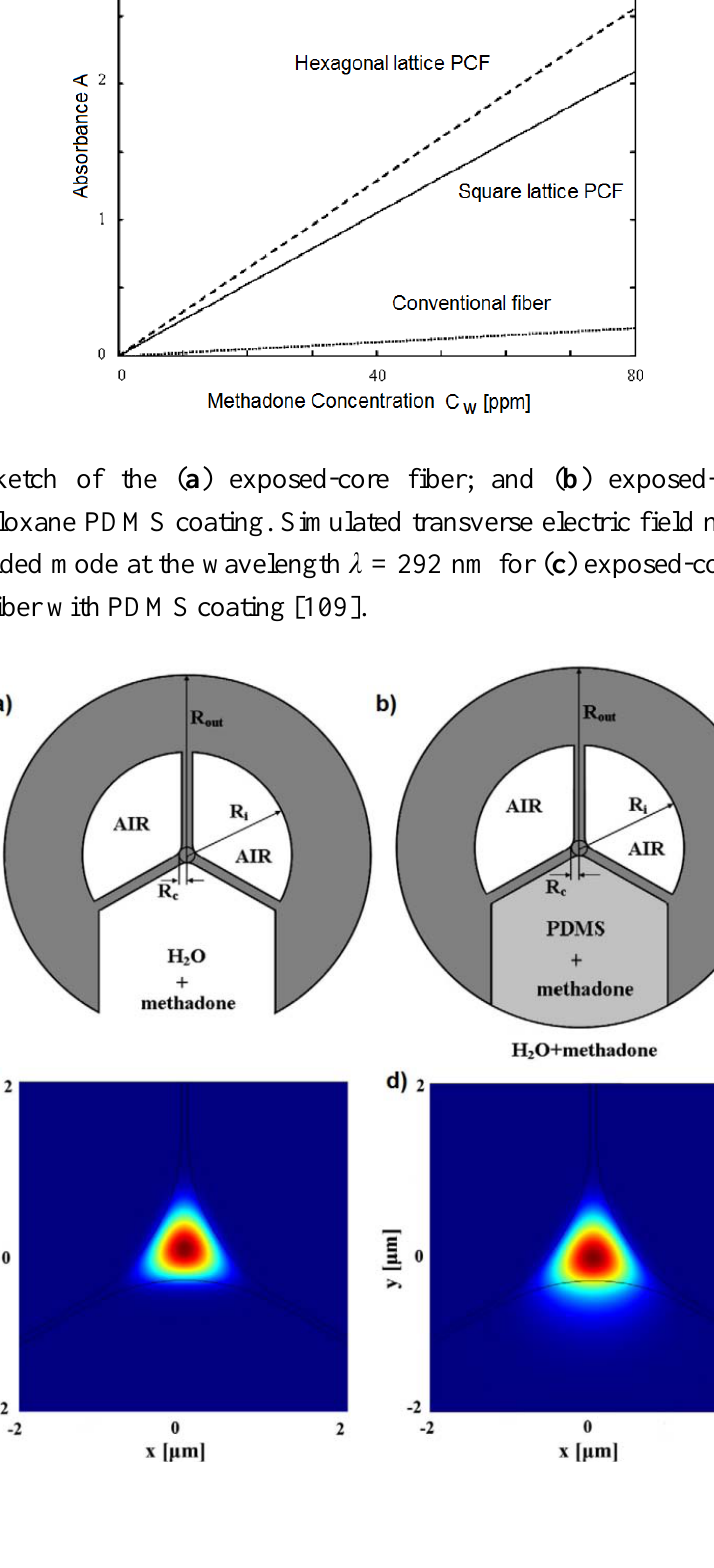
Figure 17. Absorbance A versus the methadone concentration for the square-lattice photonic crystal fibers (PCF) (full curve), hexagonal-lattice PCF (dash curve) and conventional step-index fiber (dot curve) [108].